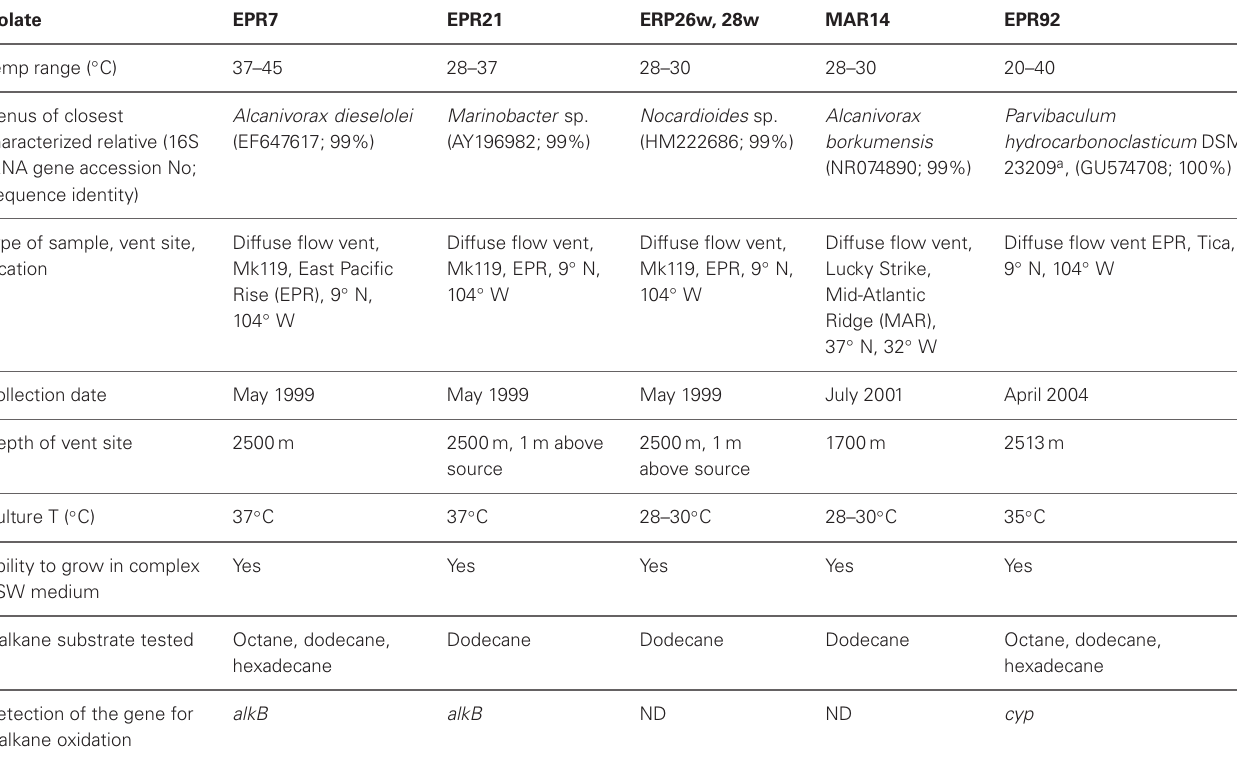
Table 1 | Characteristics of hydrothermal vent